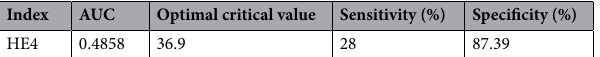
Table 5. The area under the ROC curve (AUC), optimal critical value, sensitivity and specificity of HE4 for different FIGO stages of